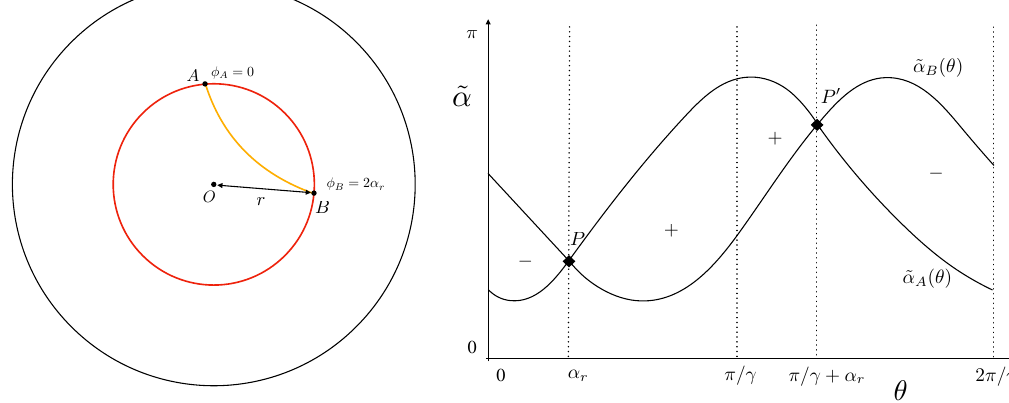
Figure 6 . Left diagram : geodesic arc (in yellow) on a constant time slice of conical AdS between two points A and B on a circle (in red) of radius r and with angular coordinates φ A = 0 and φ B = 2 α r . For simplicity, the conical parameter (cid:15) = 1 − γ is taken to be much smaller than one, so the geodesics take a similar form as those in pure AdS. Right diagram : kinematic space ( θ, ˜ α ) with point curves ˜ α A ( θ ) and ˜ α B ( θ ) corresponding to the two bulk points in the left diagram. The geodesic distance between A and B is computed by an integral in kinematic space over the region ∆ AB enclosed by the two point